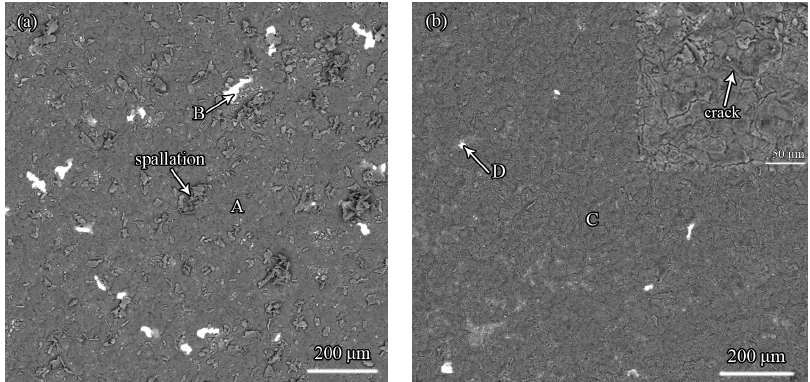
Figure 10. The surface morphologies of the coatings after oxidation at 1100 °C for 320 h: ( a ) PtAl and ( b ) PtZrAl.